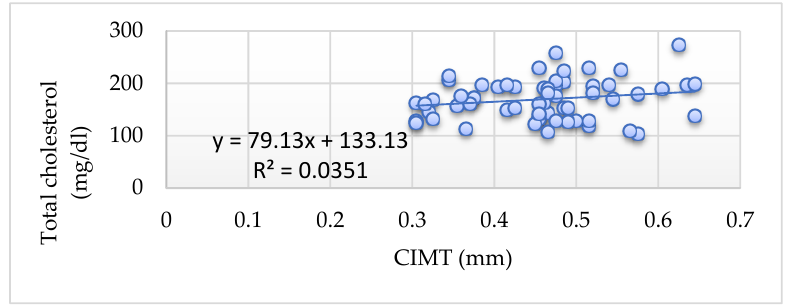
Figure 9. Correlation between CIMT and total cholesterol in all children.